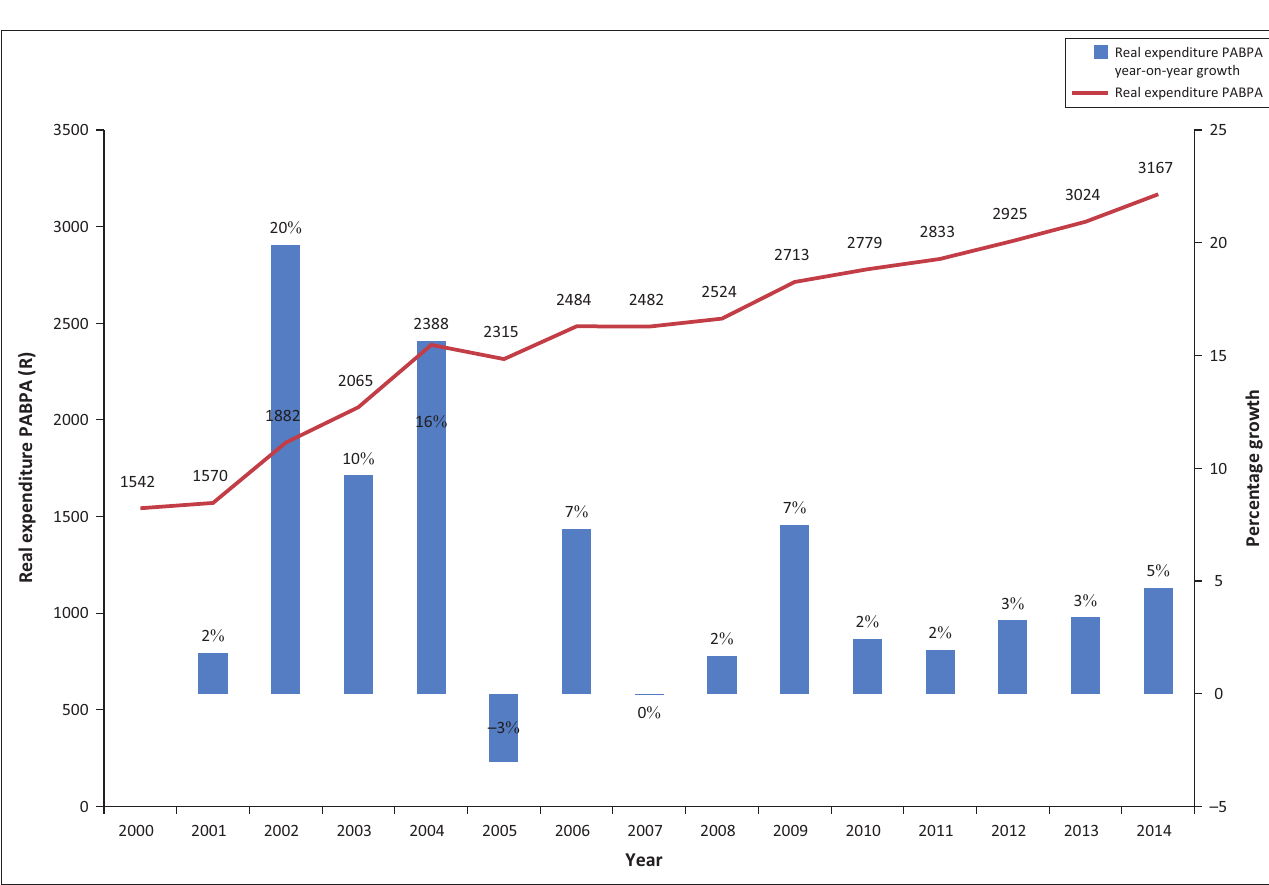
FIGURE 2: Real (Rands, 2006 = 100) per average beneficiary per annum medical scheme expenditure on private hospitals,